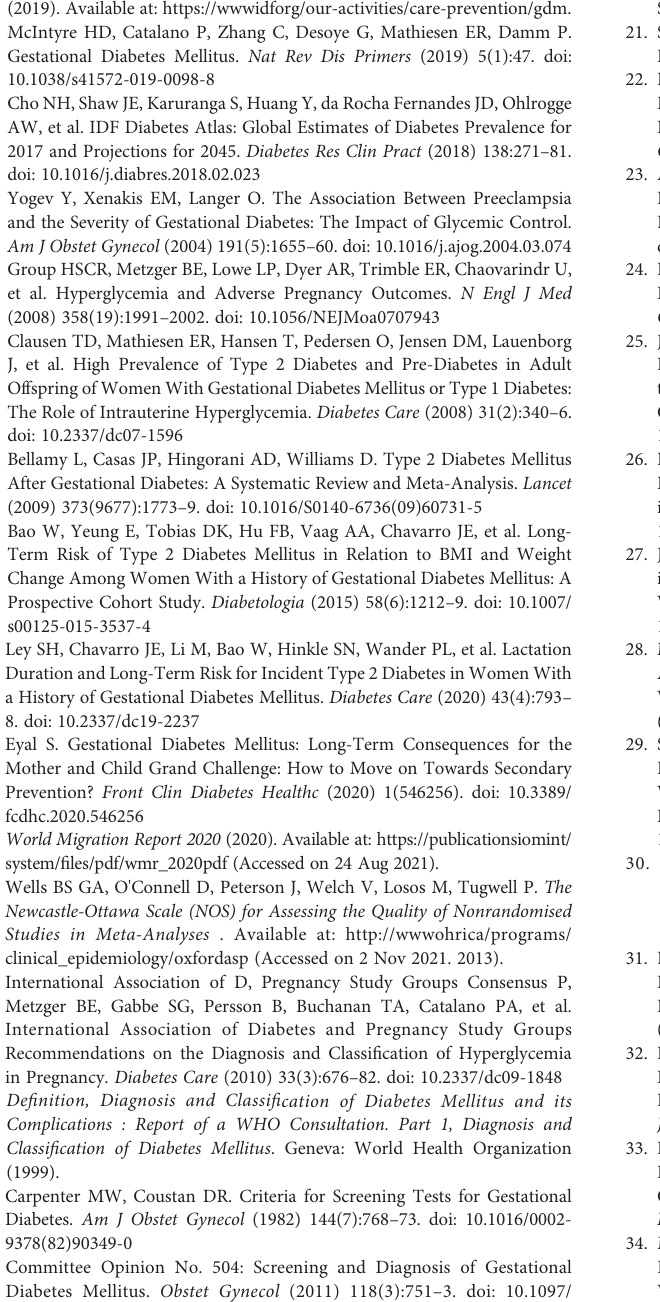
Supplementary Figure 3 | Flow diagram of search strategy and selection of GDM-related offspring postpartum health outcomes in the Asian population including Native Asians and Asian